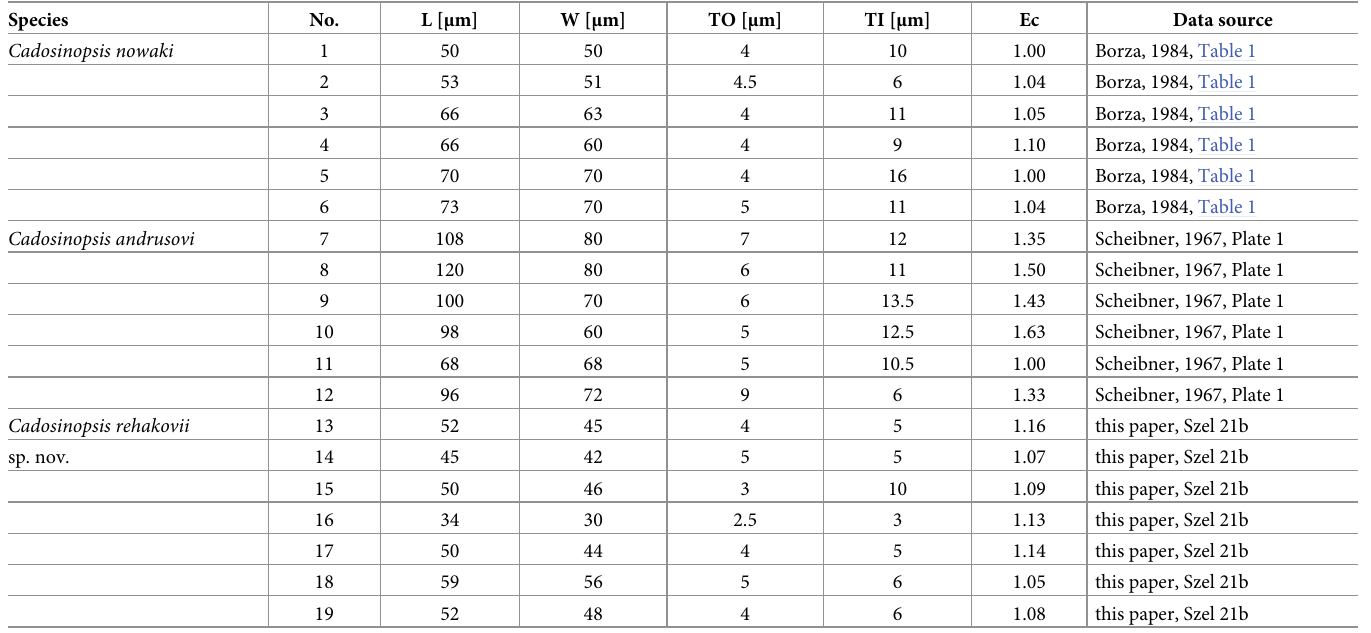
Table 2. Comparison of dimensions of the Cadosinopsis rehakovii sp. nov. and Cadosinopsis nowaki Borza, 1984, and Cadosinopsis andrusovi Scheibner, 1967. Species